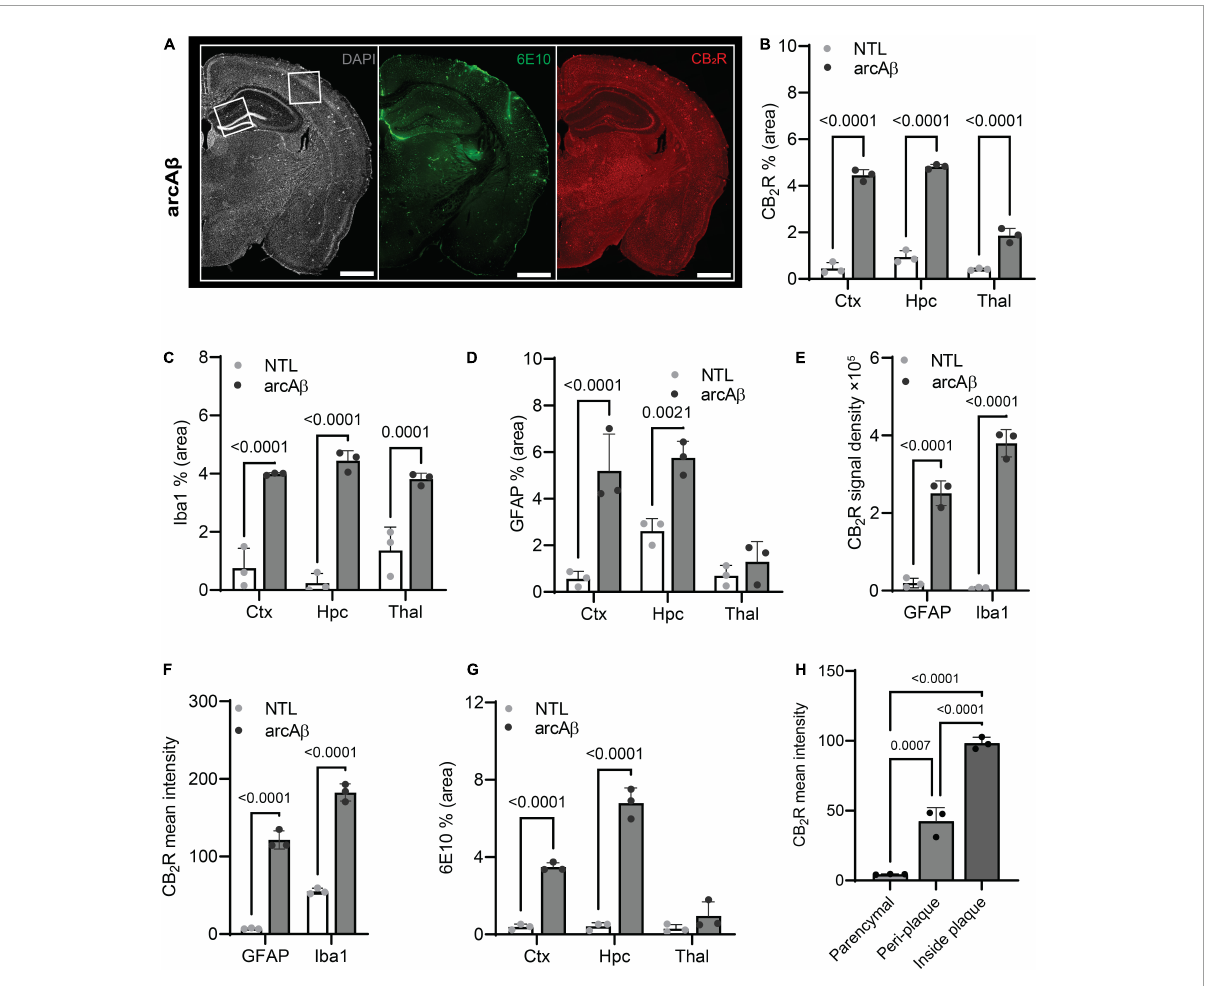
FIGURE2 Quantification of microgliosis-, astrocytosis-, cannabinoid type 2 receptor (CB 2 R), and A β plaque-associated enrichment in 17-month-old arcA β mice. (A) Representative CB 2 R (red) and 6E10 (A β , green) staining in half hemisphere of one arcA β mouse brain. White boxes in panel (A) indicate the regions including cortex (Ctx), cornu ammonus 1 (CA1) region of the hippocampus (Hpc) that zoomed-in in Figure 1 . Scale bar = 1 mm. (B) Increased CB 2 R (% area) in the Ctx, Hpc, and thalamus (Thal) of arcA β mice ( n = 3) compared to non-transgenic littermates (NTLs, n = 3). (C,D) Increased levels of Iba1 (% area) in the Ctx, Hpc, and Thal and GFAP (% area) in the Ctx and Hpc of arcA β mice ( n = 3) compared to NTL ( n = 3). (E,F) Increased CB 2 R signal density and mean signal intensity on both GFAP+ astrocytes and Iba1+ microglia of arcA β mice ( n = 3) compared to NTL ( n = 3). (G) Increased 6E10 staining of A β plaque in the Ctx and Hpc of arcA β mice ( n = 3) compared to NTL ( n = 3). (H) CB 2 R mean signal intensity on the glia inside plaque is higher than peri-plaque, with low background signal in the parenchymal of arcA β mice. Data are presented as the mean ± standard